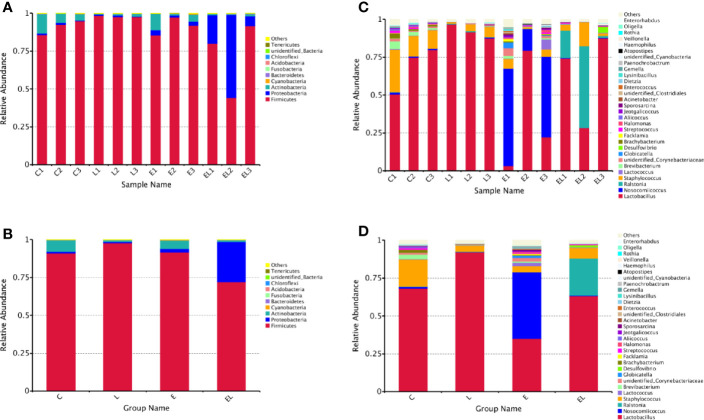
Relative abundance of the most preponderant (top 10 and 30) gut microbial taxa at phylum (top 10) and genus (top 30) levels for bacteria among four groups. (A, C) Relative abundance of gut microbiota in each sample at the phylum and genus levels. (B, D) Relative abundance of gut microbiota on the basis of the average number of each subfamily at the phylum and genus levels.